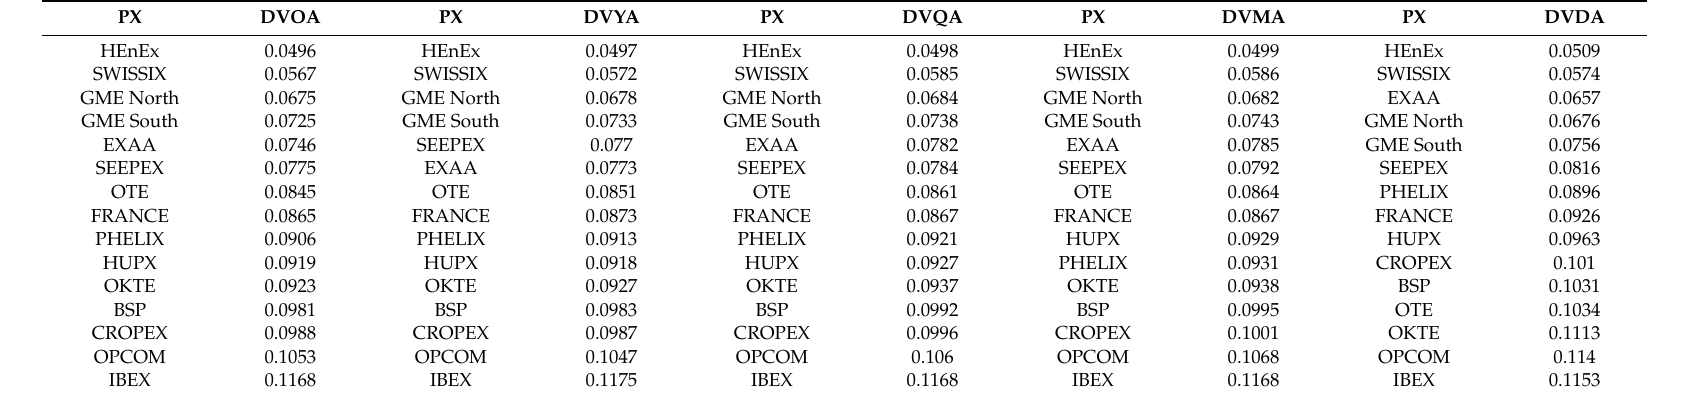
Table 3. Average price volatility for